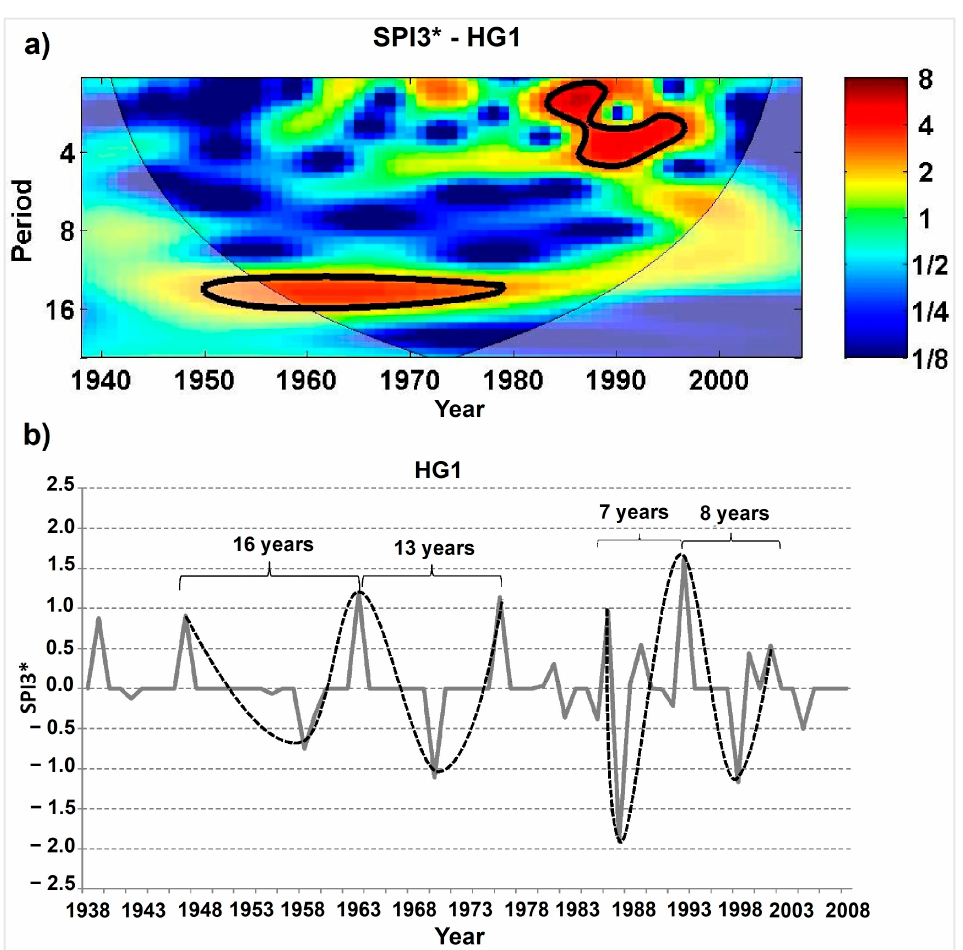
Figure 3. ( a ) Continuous wavelet power spectrum from SPI3* at HG1. The thick black contours highlight the 95% of confidence level. ( b ) SPI3* time series for HG1 with the temporal cycle of variability.